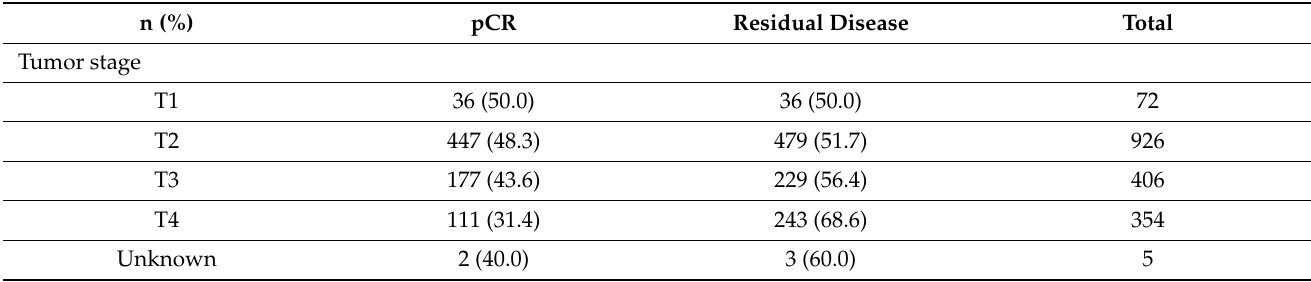
Table 2. pCR by baseline tumor and clinical stage and HER2-targeted treatment